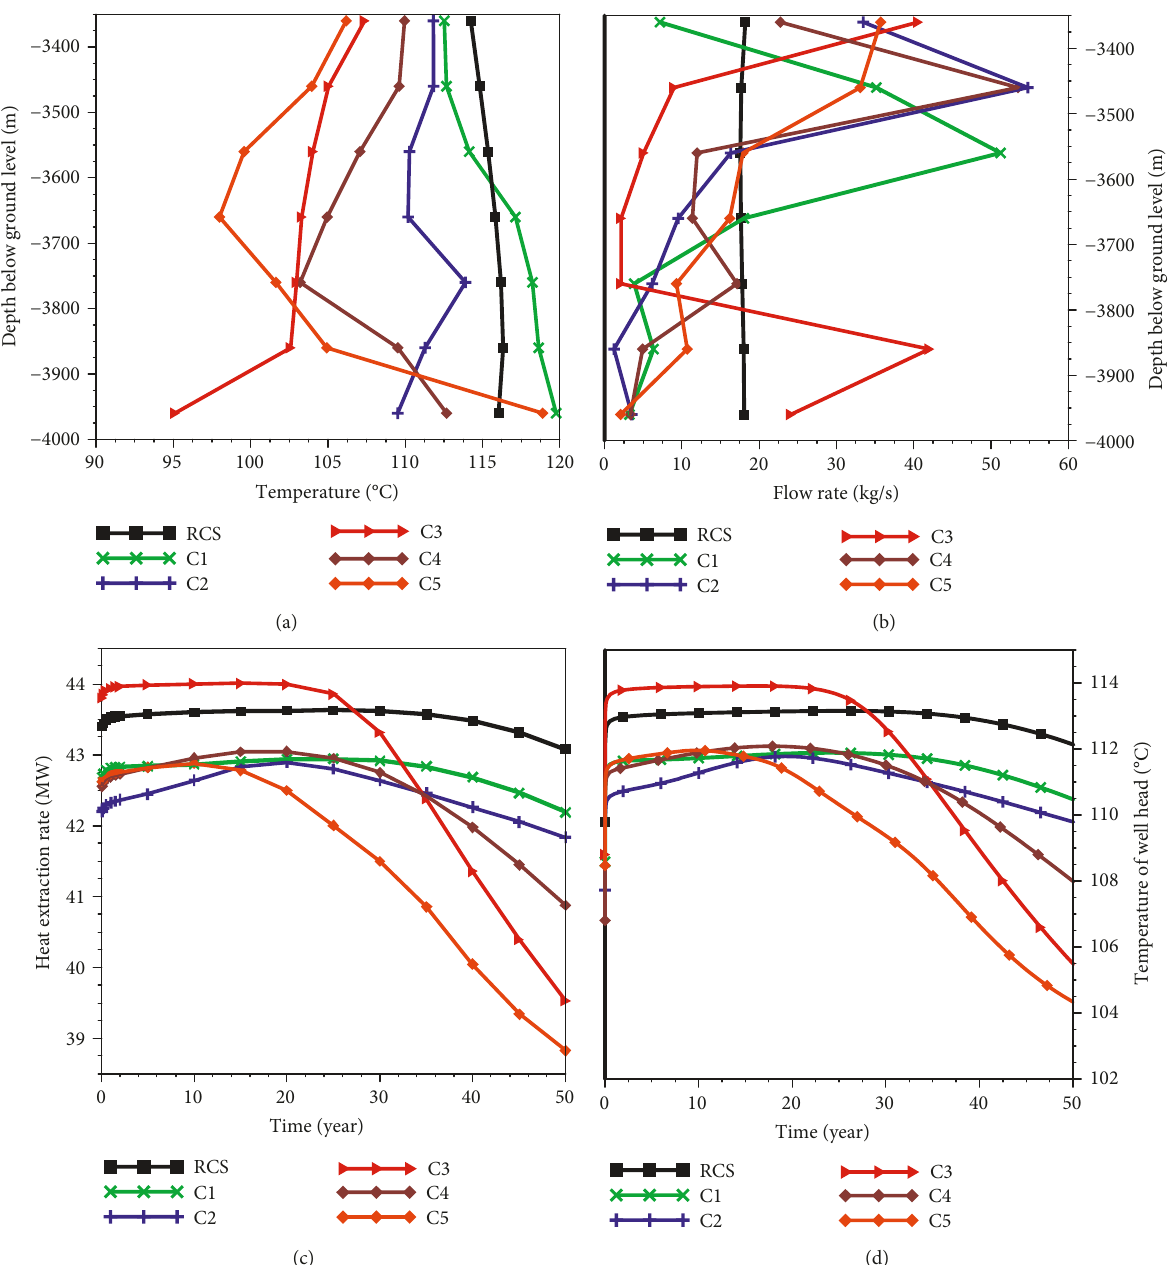
Figure 10: The temperature pro fi le (a) and fl ow rate variation (b) along open-hole section of production well after 50 years. Heat extraction rate variation (c) and output temperature variation (d) over time. Di ff erent cases including the RCS and fi ve cases (C1, C2, C3, C4, and C5) in the heterogeneity of permeability are